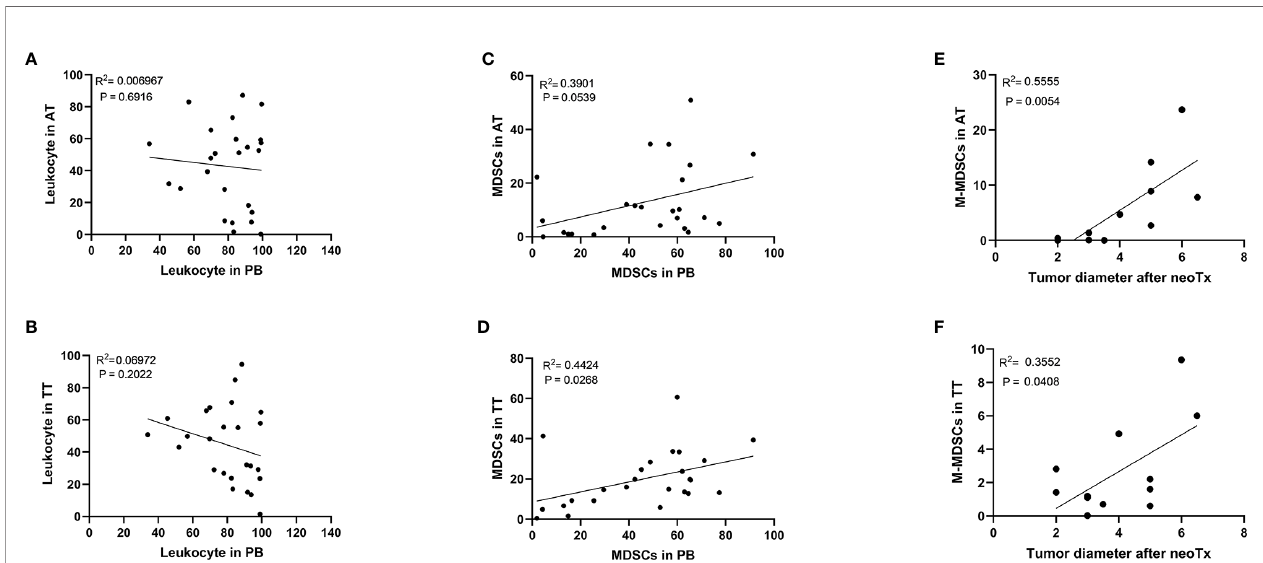
FIGURE 3 | There was no signi fi cant correlation between the frequency of the leukocyte in PB and the frequency of the leukocyte in AT (A) or TT (B) . Positive correlation between the frequency of the MDSCs in PB and the frequency of the MDSCs in AT (C) or TT (D) . The positive correlation between the tumor diameter after neoTx and the frequency of the M-MDSCs in AT (E) or TT (F) was determined. Pearson correlation coef fi cient (R 2 ) and statistical signi fi cance are presented for each